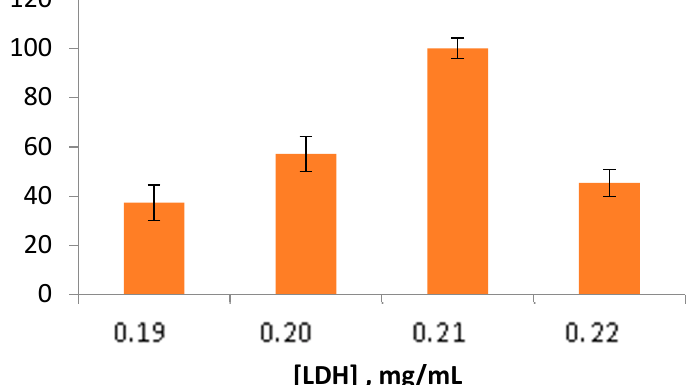
Figure 1. Values of light intensity of the LDH + Red + Luc enzyme system upon the LDH concentrations variation.